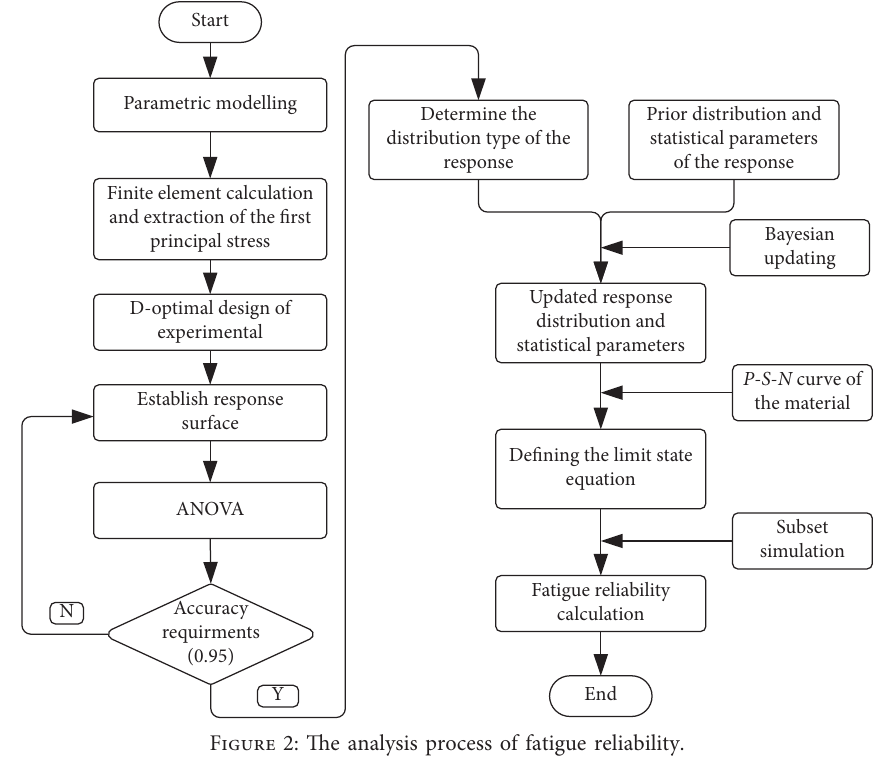
Figure 2: The analysis process of fatigue